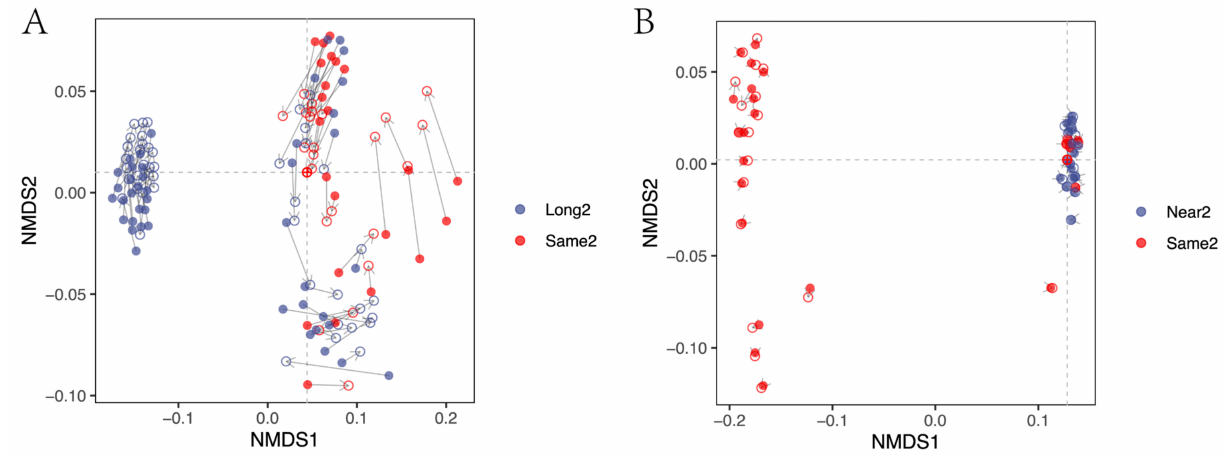
Figure 4. ( A ) Paired comparison of corrected (Long2 vs. Same2) and ( B ) non-differential (Near2 vs. Same2) effects using Procrustes analysis in the Non-metric Multi-dimensional Scaling (NMDS) space. The filled point is for pre-treatment samples; the hollow circle is for post-treatment samples. The red point in the crossing of two dashed lines is the medoids. The M2 value is calculated by Procrustes analysis to evaluate the overall difference between the two datasets. The p -value is calculated by t -test with H0: there is no difference in the vector of the effectiveness of the correction ( ∆ E ) compared to